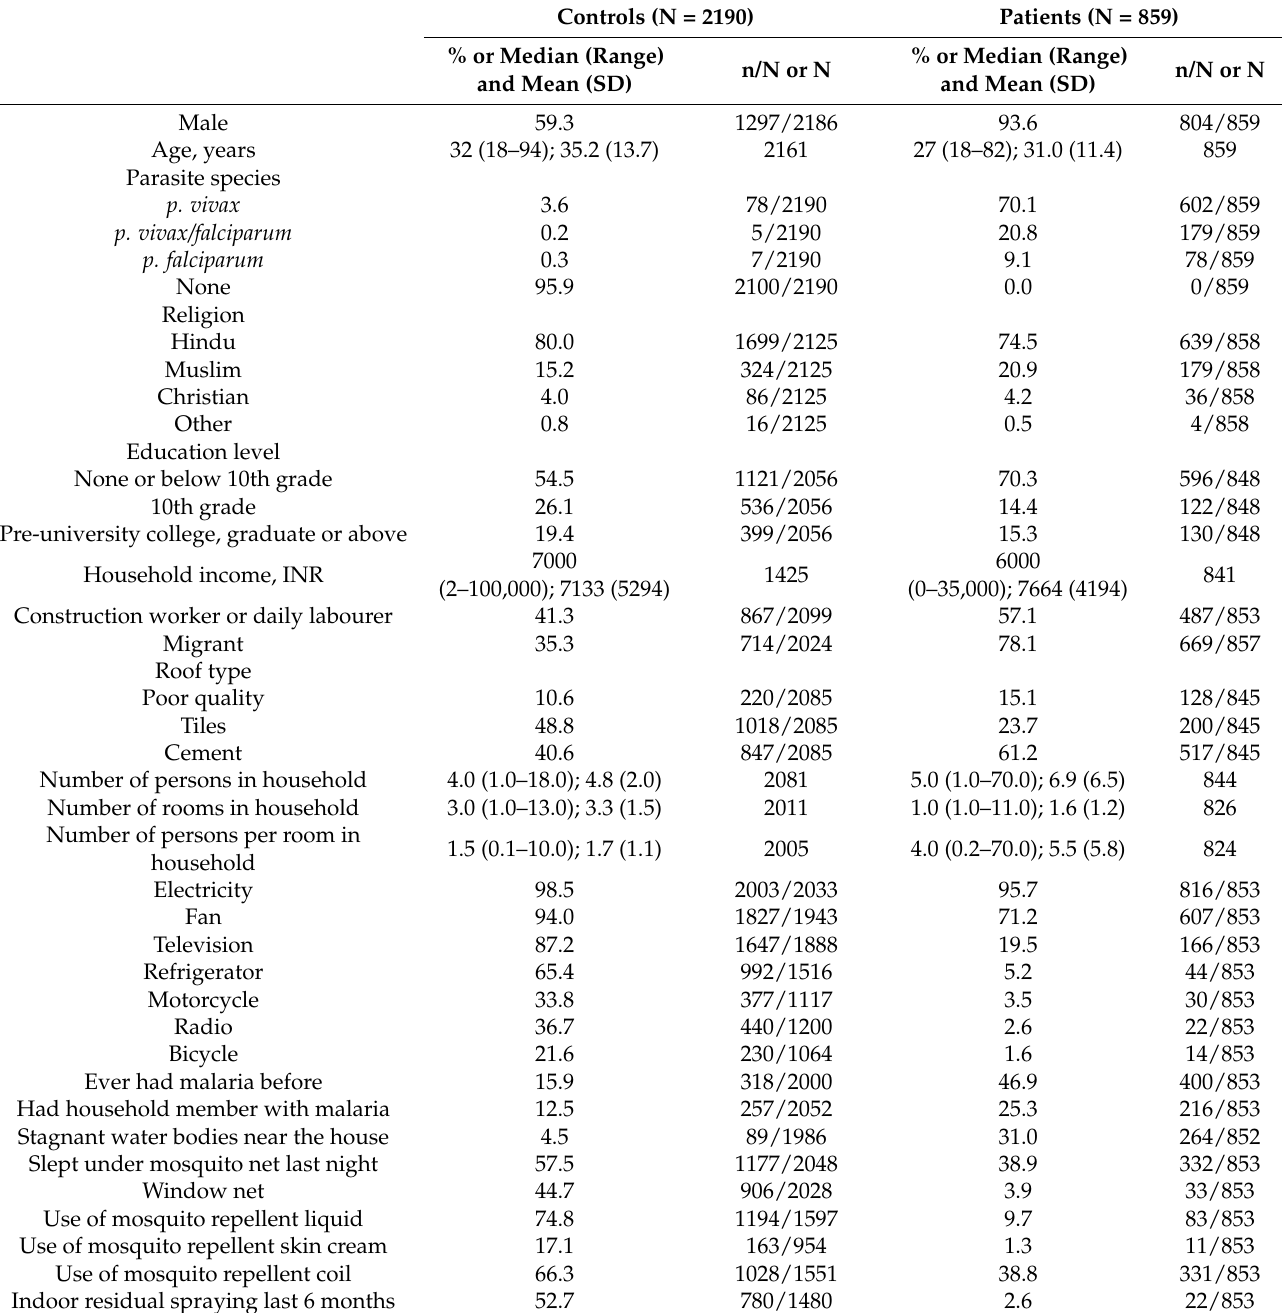
Table 1. Descriptive statistics of the study population, including demographic and socioeconomic variables 1 used for analysis and/or